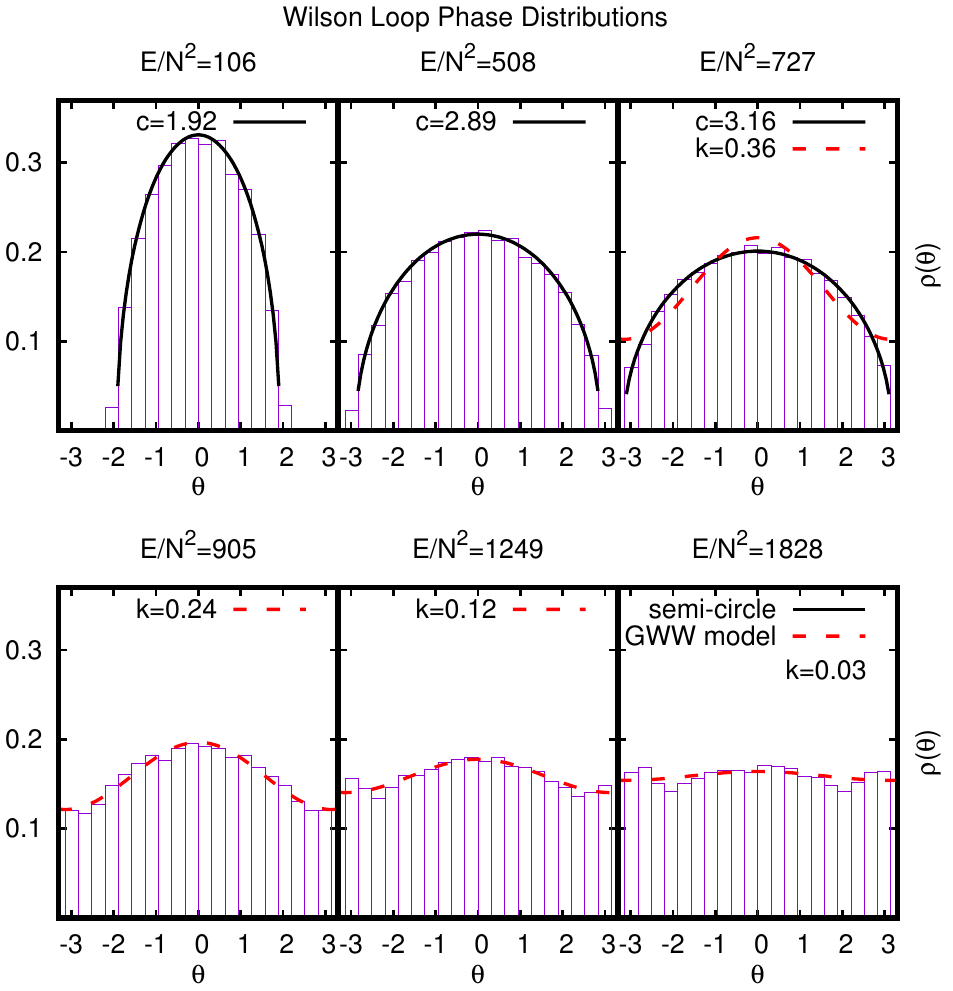
Figure 5 . Wilson loop phase distribution (cid:26) ( (cid:18) ) for various energies. For E=N 2 (cid:20) 750, the results can be (cid:12)t well by a semi-circle distribution (2.13) with (cid:12)t parameter c , whereas for E=N 2 ’ 900, results are well (cid:12)t in terms of the Gross-Witten-Wadia (GWW) model (2.16) with (cid:12)t parameter k. Best-(cid:12)t values for c; k are indicated in individual plots